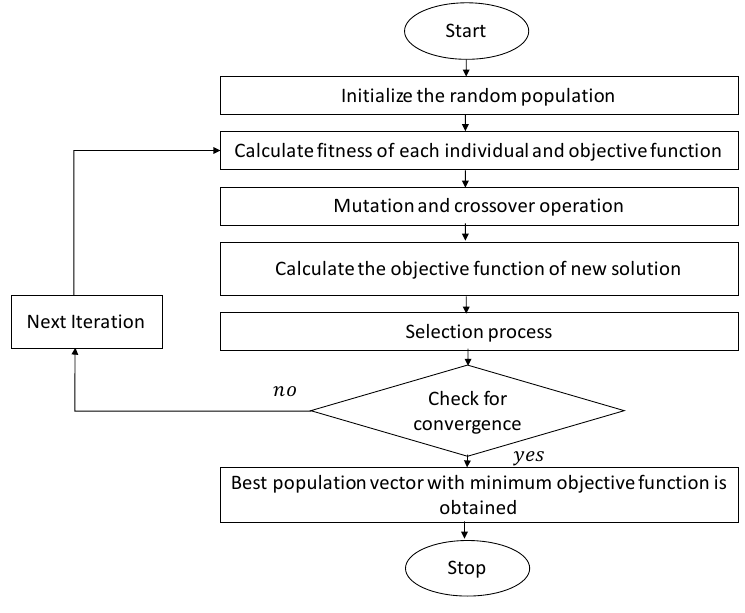
Figure 1. Flowchart of the DE algorithm.